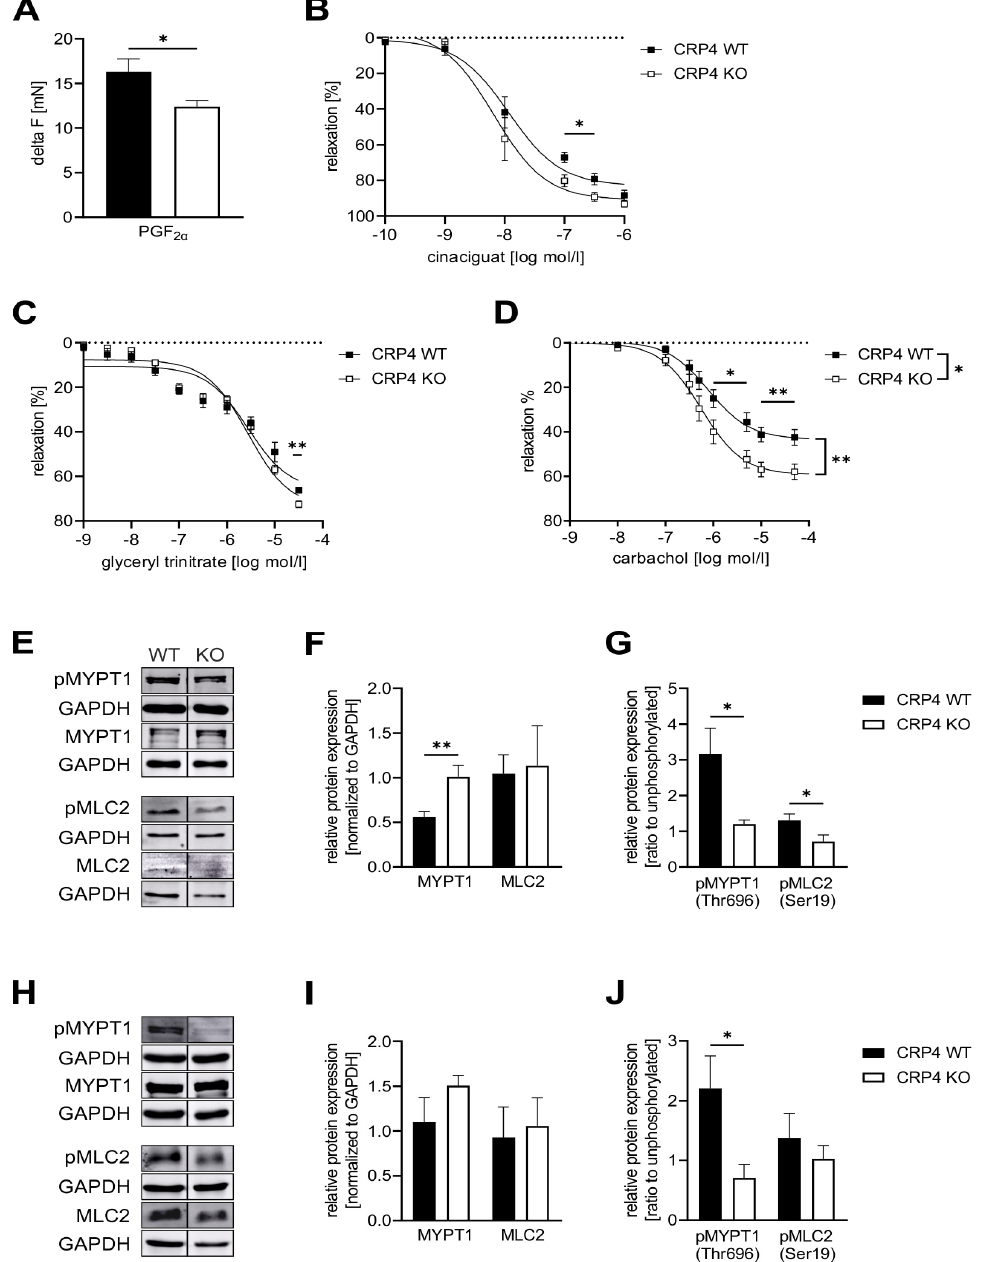
Figure 3. Lack of CRP4 facilitates Ca 2+ desensitization mechanisms and cGMP-mediated effects on vascular tone. ( A ) Maximal contraction (delta F (mN)) elicited by Prostaglandin F2 α (PGF 2 α ) (7.5 µ M) was significantly reduced in CRP4 KO vs. CRP4 WT aortic rings equilibrated in an organ bath. Data represent means ± SEM with n = 8–12 per genotype, * p < 0.05, two-tailed students t -test. ( B – D ) Dose-dependent relaxation of aortic ring segments was examined upon precontraction with PGF 2 α for ( B ) cinaciguat (0.1 nM to 1 µ M), ( C ) glyceryl trinitrate (1 nM to 10 mM) and ( D ) carbachol (1 nM to 10 mM)). Continuously, maximal vasorelaxation was significant improved in CRP4 KO aortic ring segments. Relaxation is expressed as percent in comparison to the maximal contraction induced by PGF 2 α . Data points represent means ± SEM with n = 4 per genotype for cinaciguat, n = 5–6 per genotype for glyceryl trinitrate, and n = 6–9 per genotype for carbachol. * p < 0.05 or ** p < 0.01 represent the statistical difference in responses between the presence, and the absence of cinaciguat, glyceryl trinitrate, or carbachol to PGF 2 α contracted rings, two-tailed students t -test, two-way ANOVA with an uncorrected Fisher’s LSD used as a post hoc test. ( E – G ) Western Blot analysis of ( E ) total myosin phosphatase target subunit 1 (MYPT1), pMYPT1 (Thr-696), total myosin light chain 2 (MLC2), and pMLC2 (Ser-19) levels in CRP4 WT and KO VSMCs co-detecting